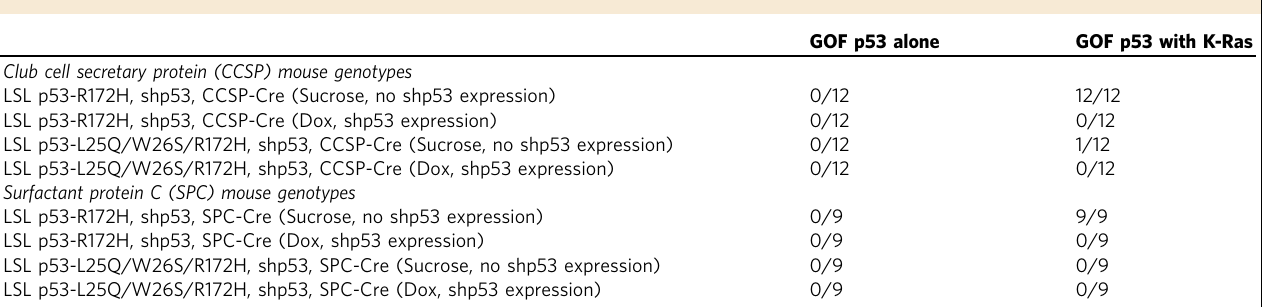
Table 1 Lung tumor formation by GOF p53 and K-Ras expression.